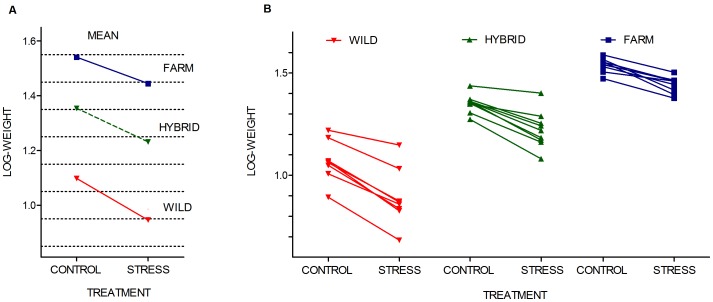
Growth reaction norms of Atlantic salmon.Log-weight norm of reaction across treatments at the a) group level and b) family level for salmon of wild, hybrid and farmed origin. Replicated tanks are pooled. The elevation of the reaction norms was significantly different in the farmed, hybrid and wild salmon. Wild salmon displayed significantly steeper slopes than the farmed salmon, while hybrid salmon displayed slopes insignificantly different to the farmed and wild salmon.